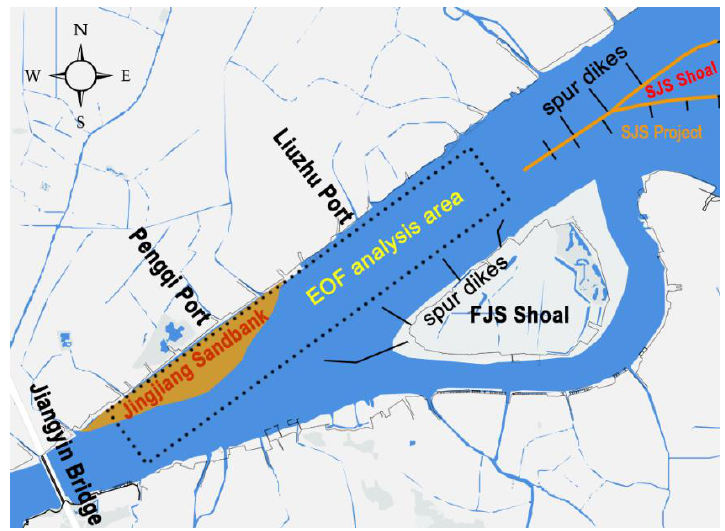
Figure 7. The area for empirical orthogonal function (EOF) analysis. The spur dikes are excluded to reduce the variance impact near artificial structures.